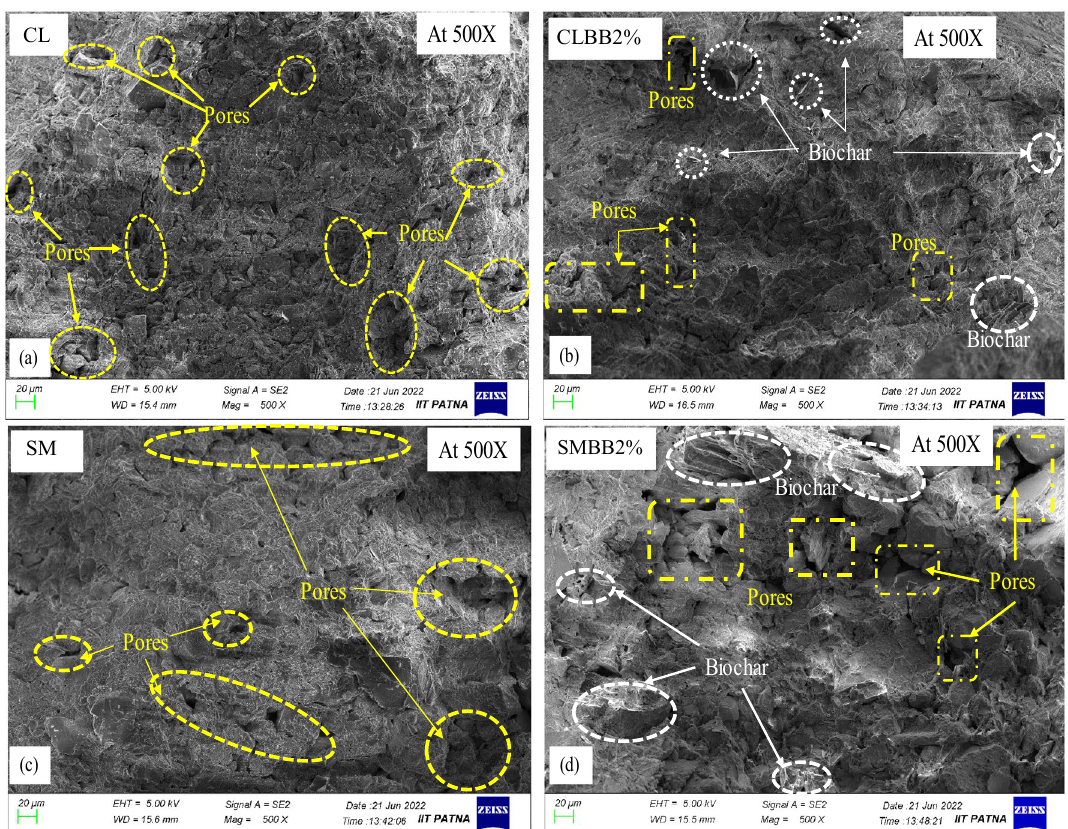
Figure 7. The change in pores and particle arrangement in the surface morphology of UCS specimens analysed at 500 magnification for ( a , c ) non amended CL, SM soil, and ( b , d ) CL, SM soil mixed with 2% (w/w) biochar